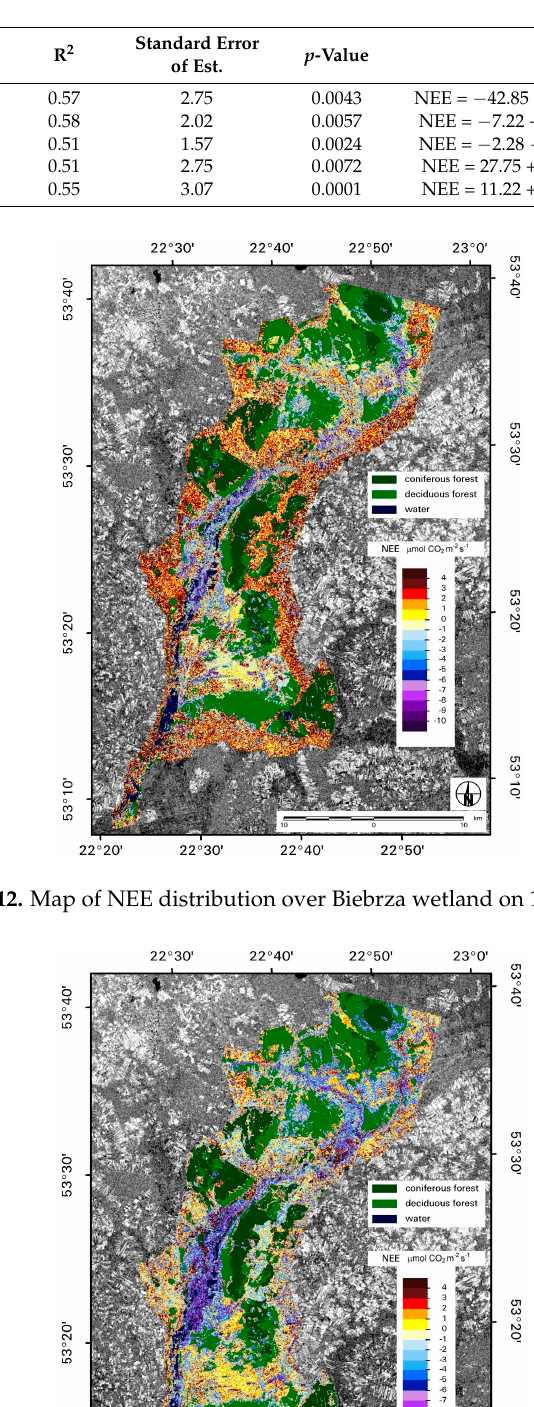
Table 7. NEE (Net Ecosystem Exchange) models at 95% confidence level derived by applying in-situ and Sentinel-1 satellite data.